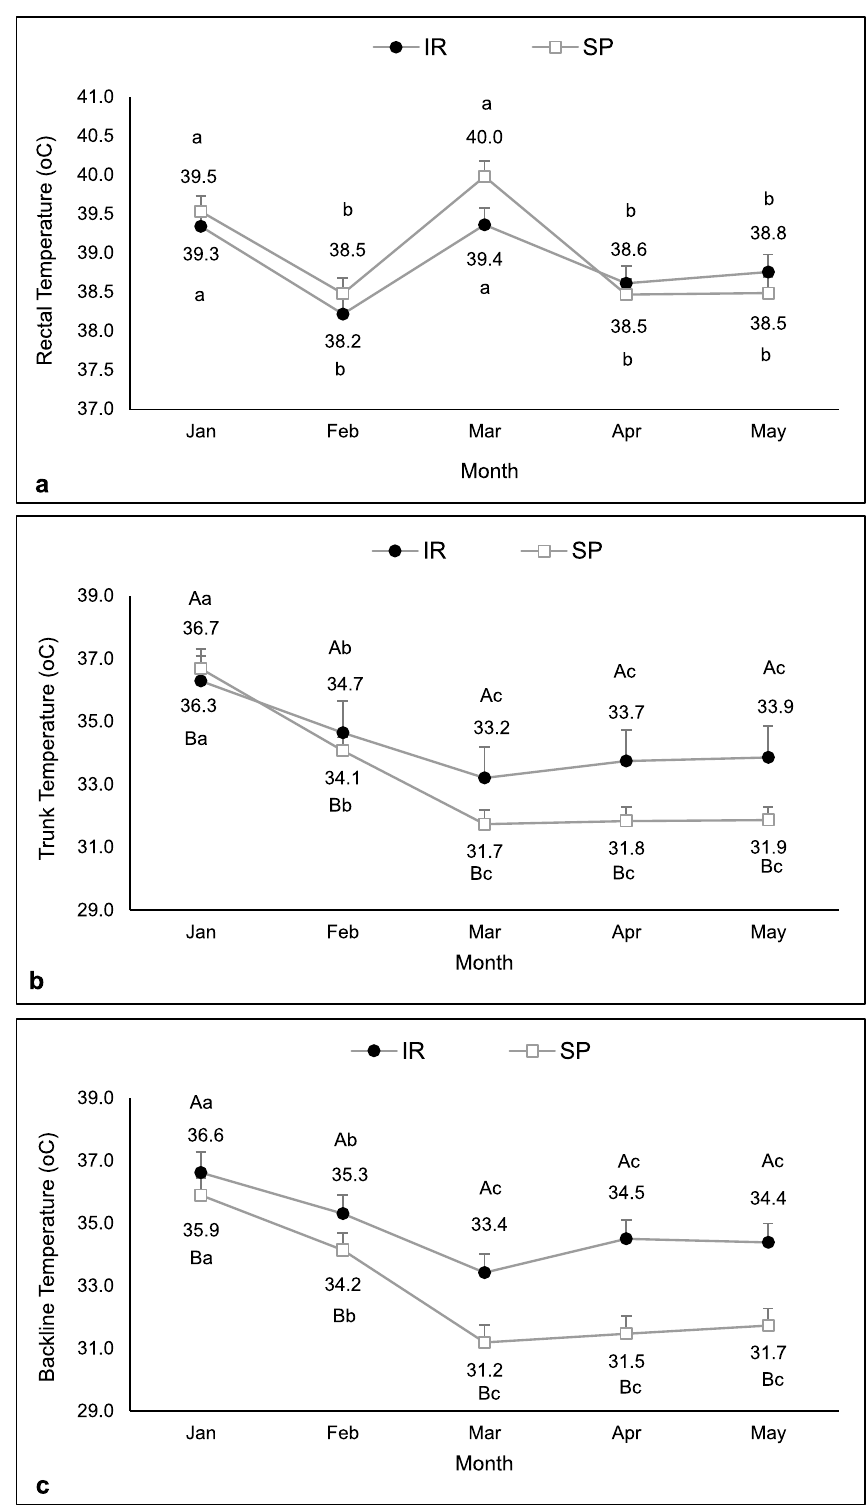
Figure 7. Rectal ( a ), trunk ( b ), and back line ( c ) temperatures of cows kept in the silvopastoral (SP) or intensive rotational (IR) grazing systems from January to May 2017. An effect of month was observed for rectal temperature. Trunk and back line temperatures were affected by both main effects. A,B Different capital letters indicate a significant difference between systems. a,b,c Different lowercase letters indicate a significant difference between